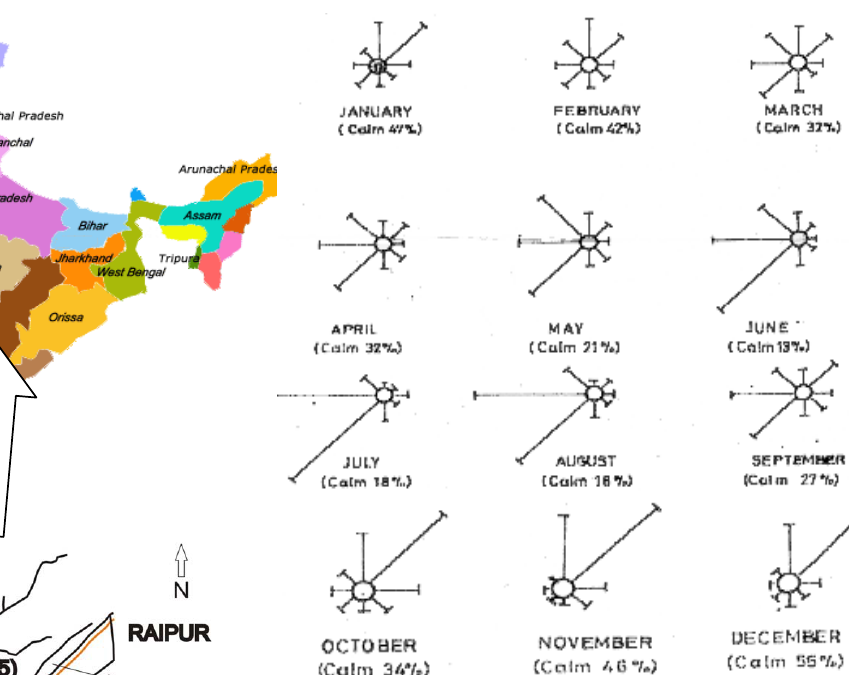
Fig. 2. Wind rose diagram of Bhilai region during March 2005– February Fig. 02: Wind rose diagram of Bhilai region during March’ 2005 – February’ 2006